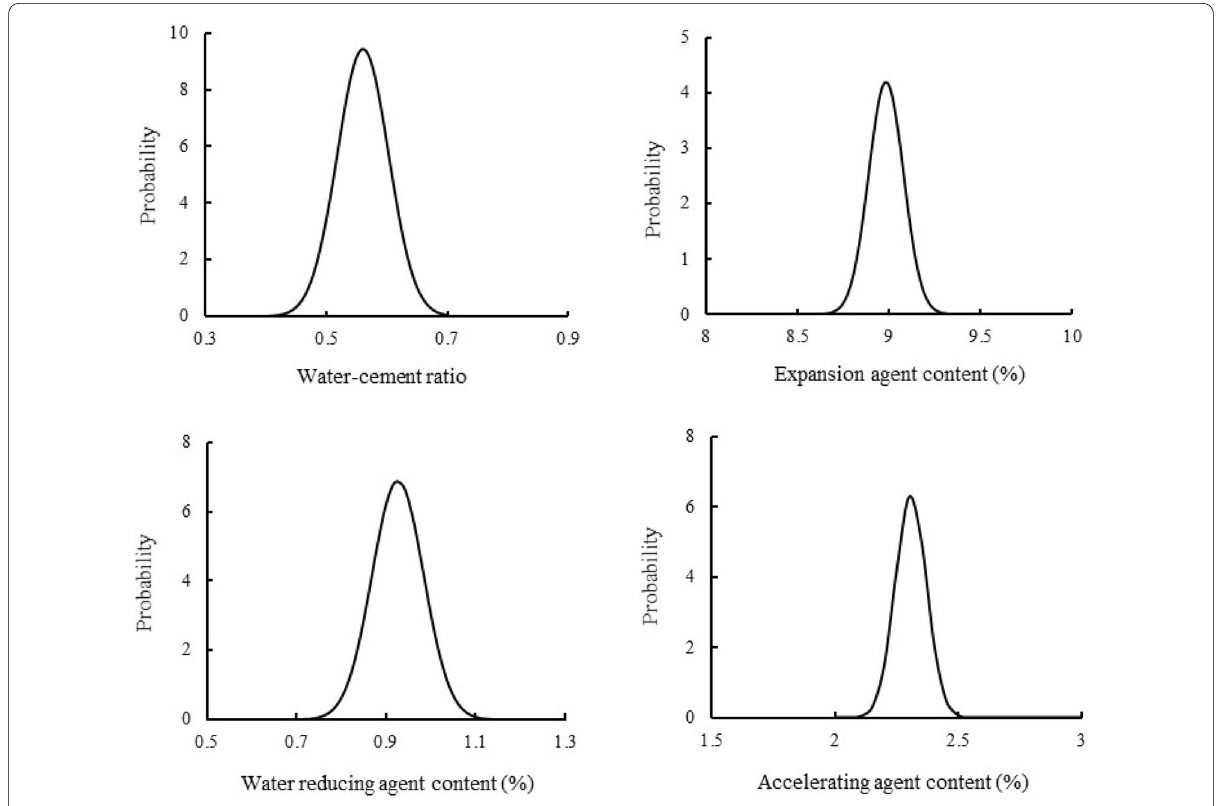
Fig. 8 Probability of different design factors